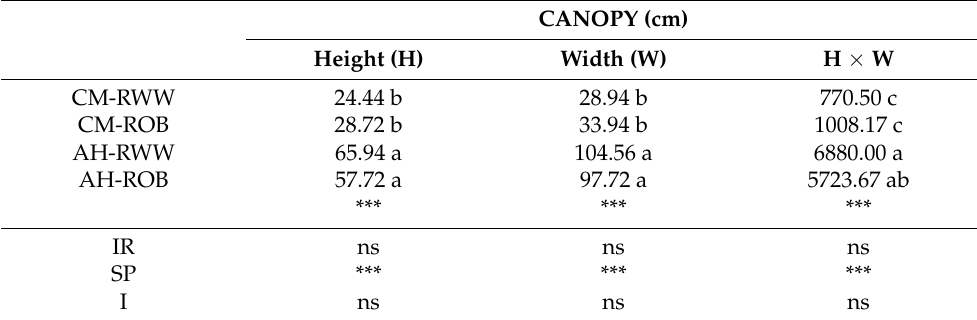
Table 6. Plant canopy determined by measuring height and width of plants in Crithmum maritimum (CM) and Atriplex halimus (AH), irrigated with reclaimed wastewater (RWW) and reverse osmosis brine (ROB). Results were from one-way and two-way ANOVA tests on these parameters for in- dependent variables (irrigation, IR, and species, SP) and their interaction (I). Values are means of three